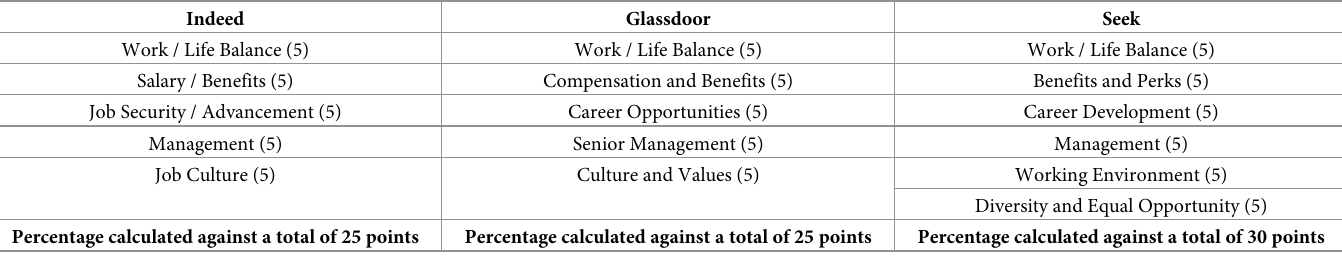
Table 1. Employee rating themes and rating scales across three